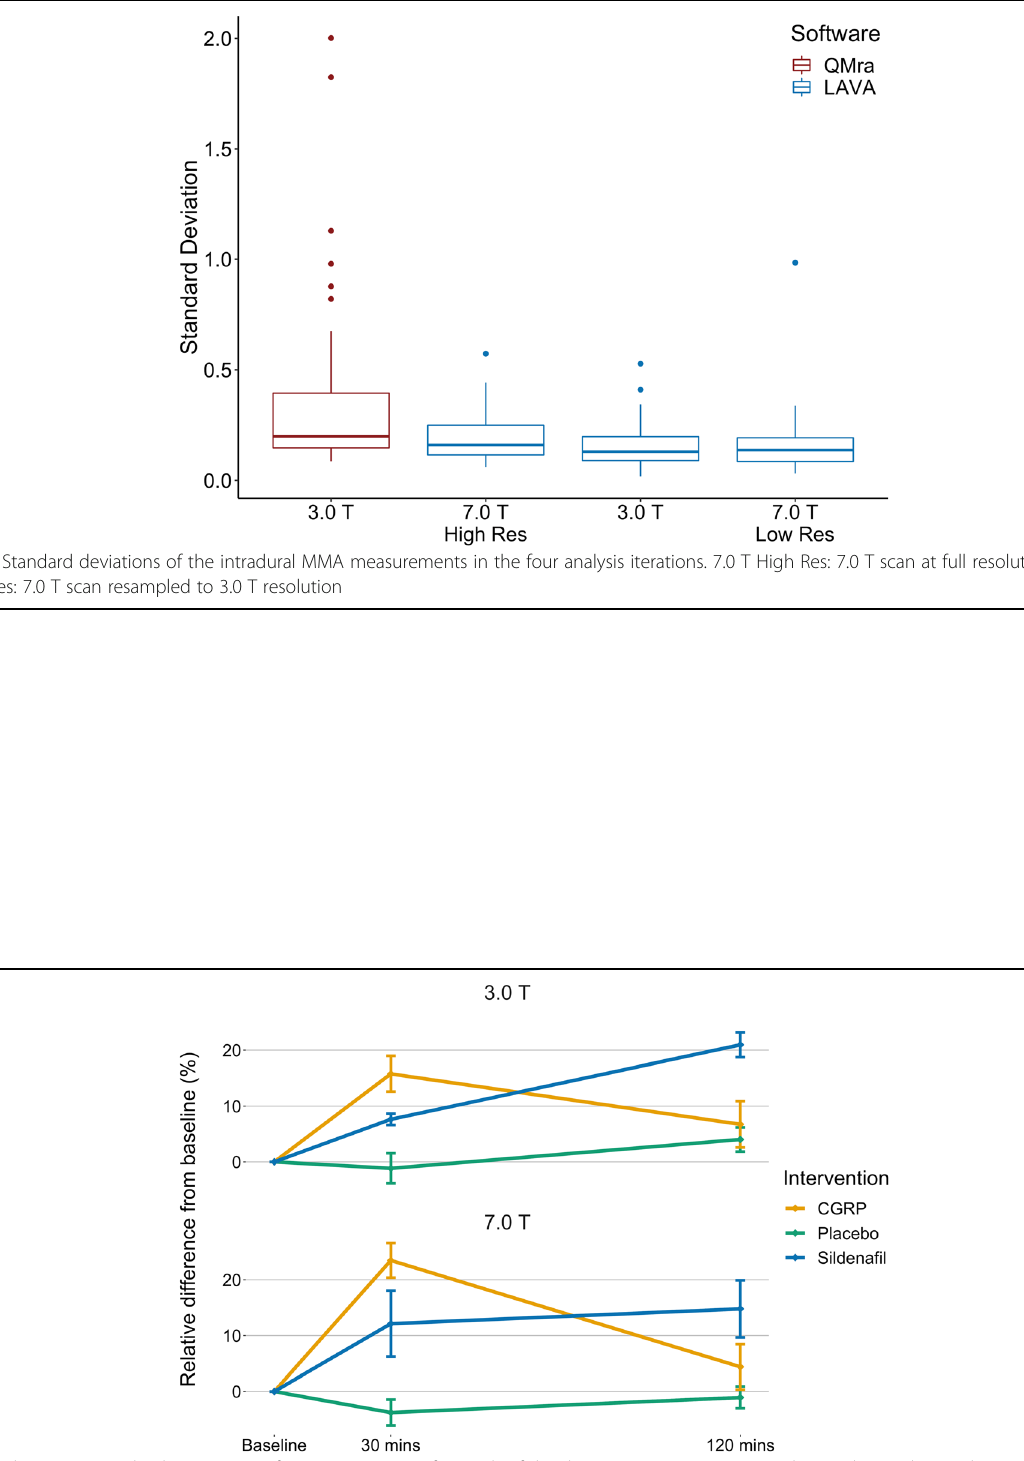
Fig. 2 Change in intradural MMA circumference over time after each of the three interventions. 3.0 T and 7.0 T data is depicted as mean ± SE, all data analyzed with LAVA software